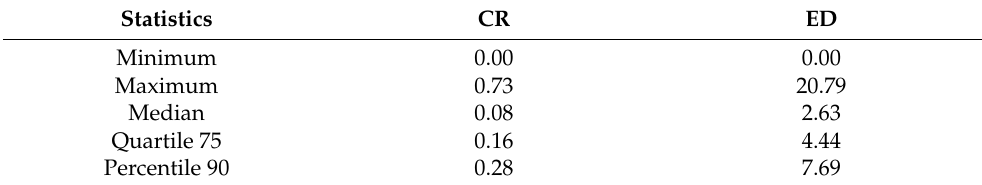
Table 3. Descriptive statistics of the pair-wise matrix consistency criteria CR and ED. Statistics CR